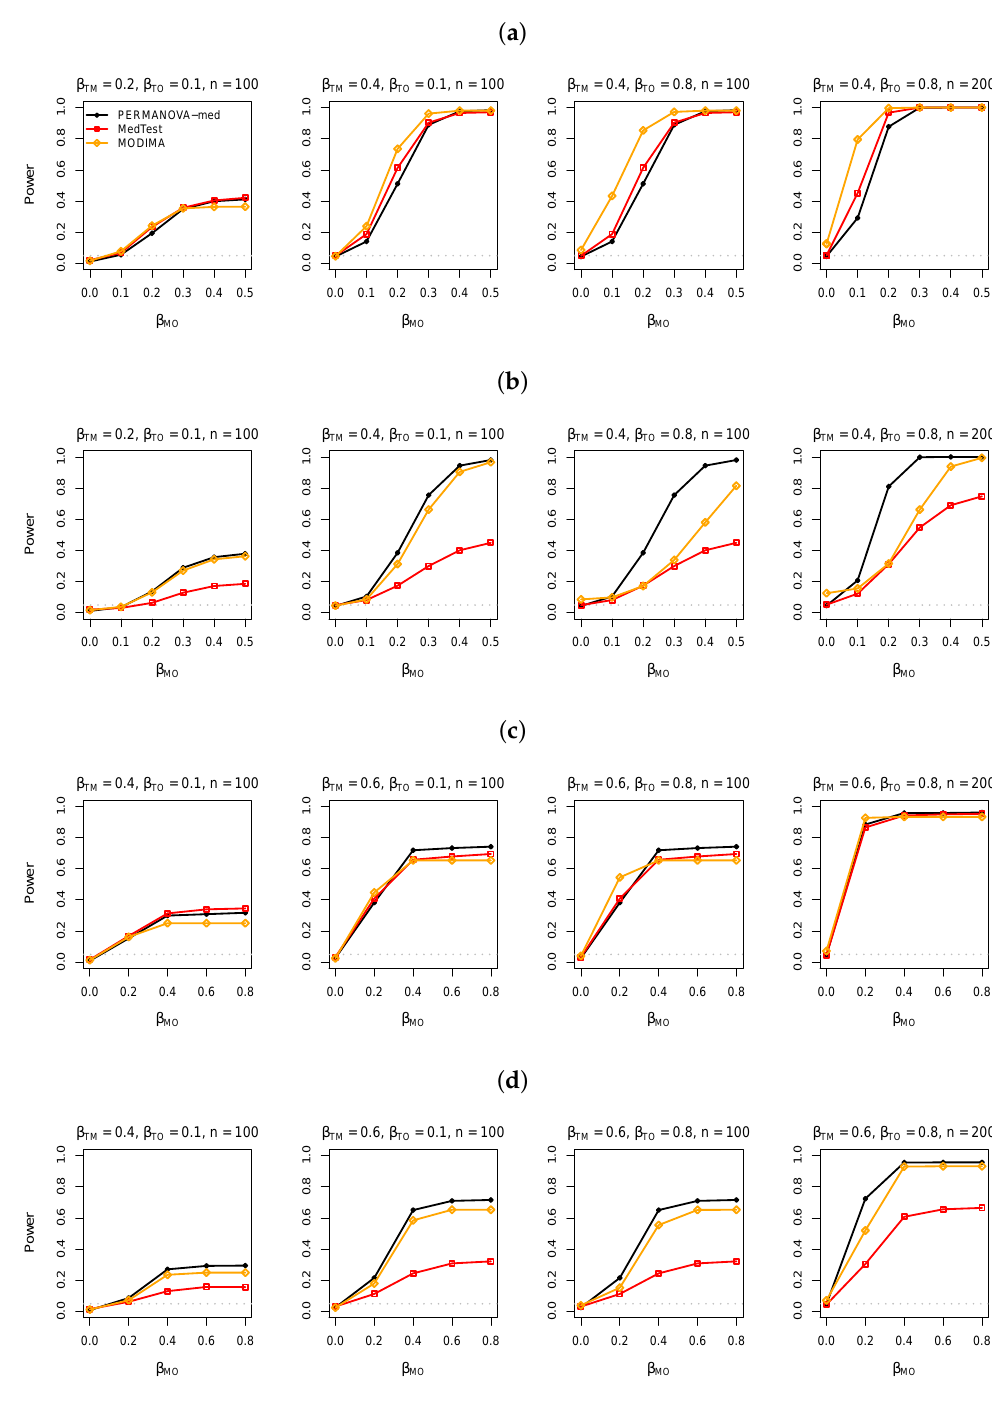
Figure 3. Simulation results in analysis of simulated data under M-common. ( a ) Binary exposure, taxa 1–5 for the M-O association. ( b ) Binary exposure, taxa 4 and 5 for the M-O association. ( c ) Con- tinuous exposure, taxa 1–5 for the M-O association. ( d ) Continuous exposure, taxa 4 and 5 for the M-O